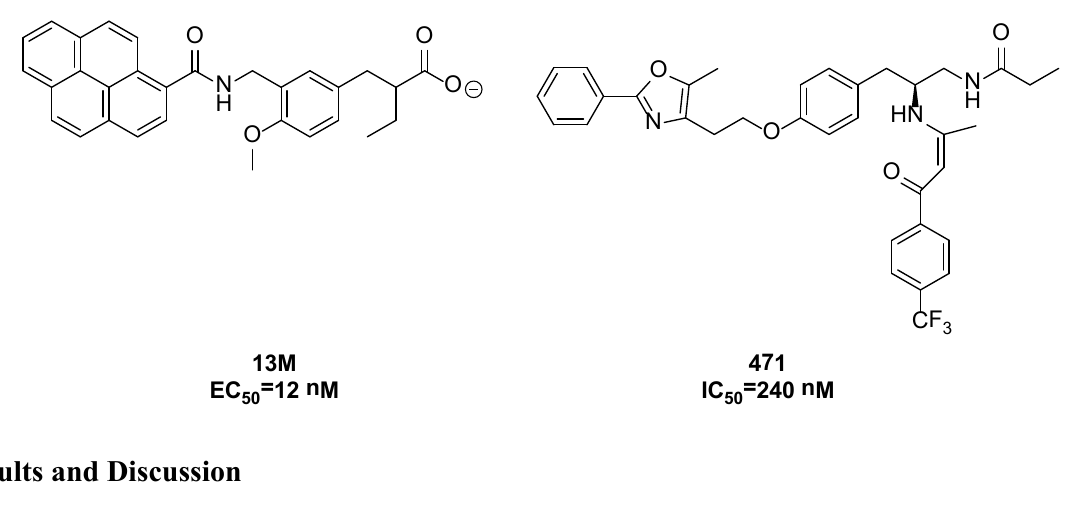
Figure 3. Chemical structures of PPAR-α agonist 13M and antagonist 471.